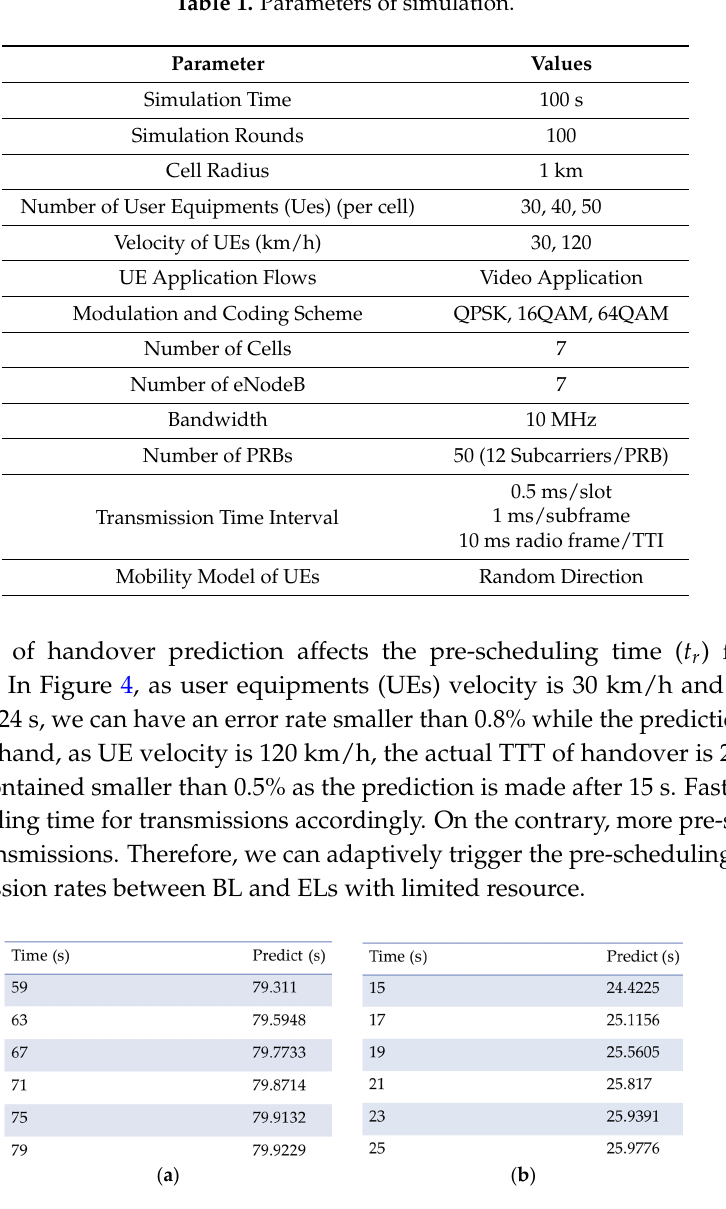
Table 1. Parameters of simulation.